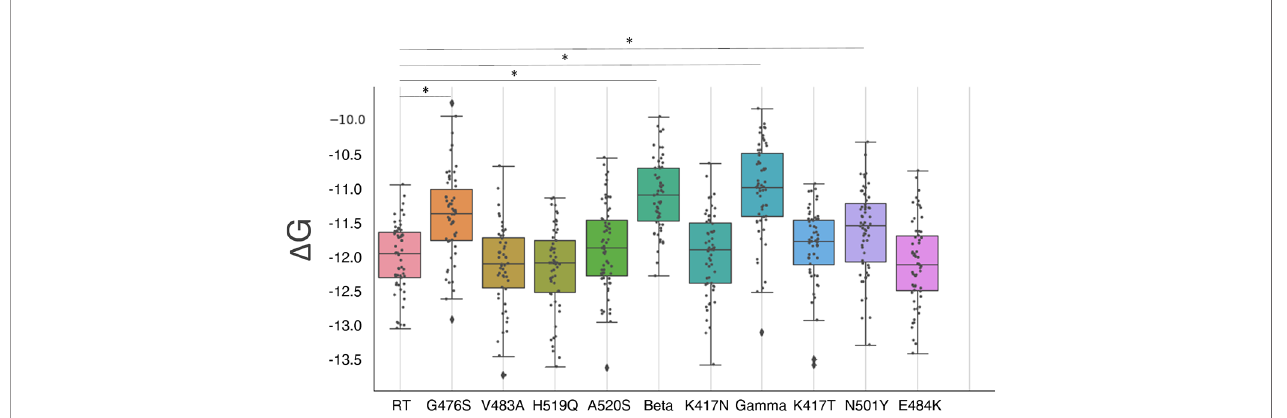
FIGURE 3 | Box plots of the distribution of S-RBD and hACE2 receptor binding free energy. A boxplot is constructed of two parts, a box and a set of whiskers. The box is drawn from the fi rst quartile ( Q 1 , the median of the lower half of the dataset) to the third quartile ( Q 3 , the median of the upper half of the dataset) with a horizontal line drawn in the middle to denote the median. The whiskers are drawn from the upper/lower quartile to the largest/lowest data point excluding any outliers. The outliers are shown with black diamonds. Statistically different distributions are indicated with a (*) symbol. G476 mutant, alpha (N501Y), beta, and gamma variants show a worse binding af fi nity. However, the differences in absolute value are